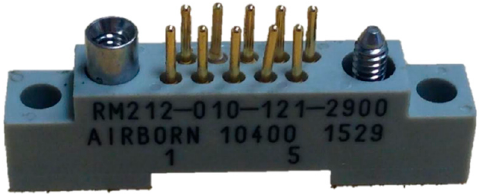
Figure 8. The rectangular MIL specification connector with ten pins in total. The metal pin on the left is the reference peg.